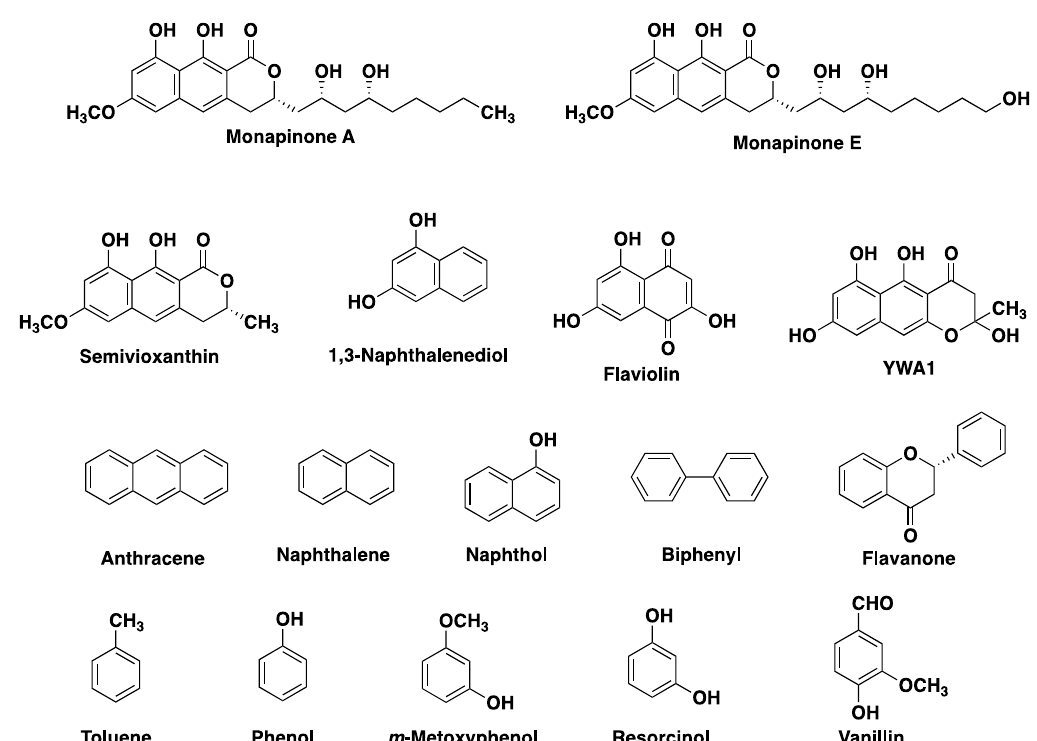
Figure 2. Cyclic compounds used to examine the substrate specificity of MCE.